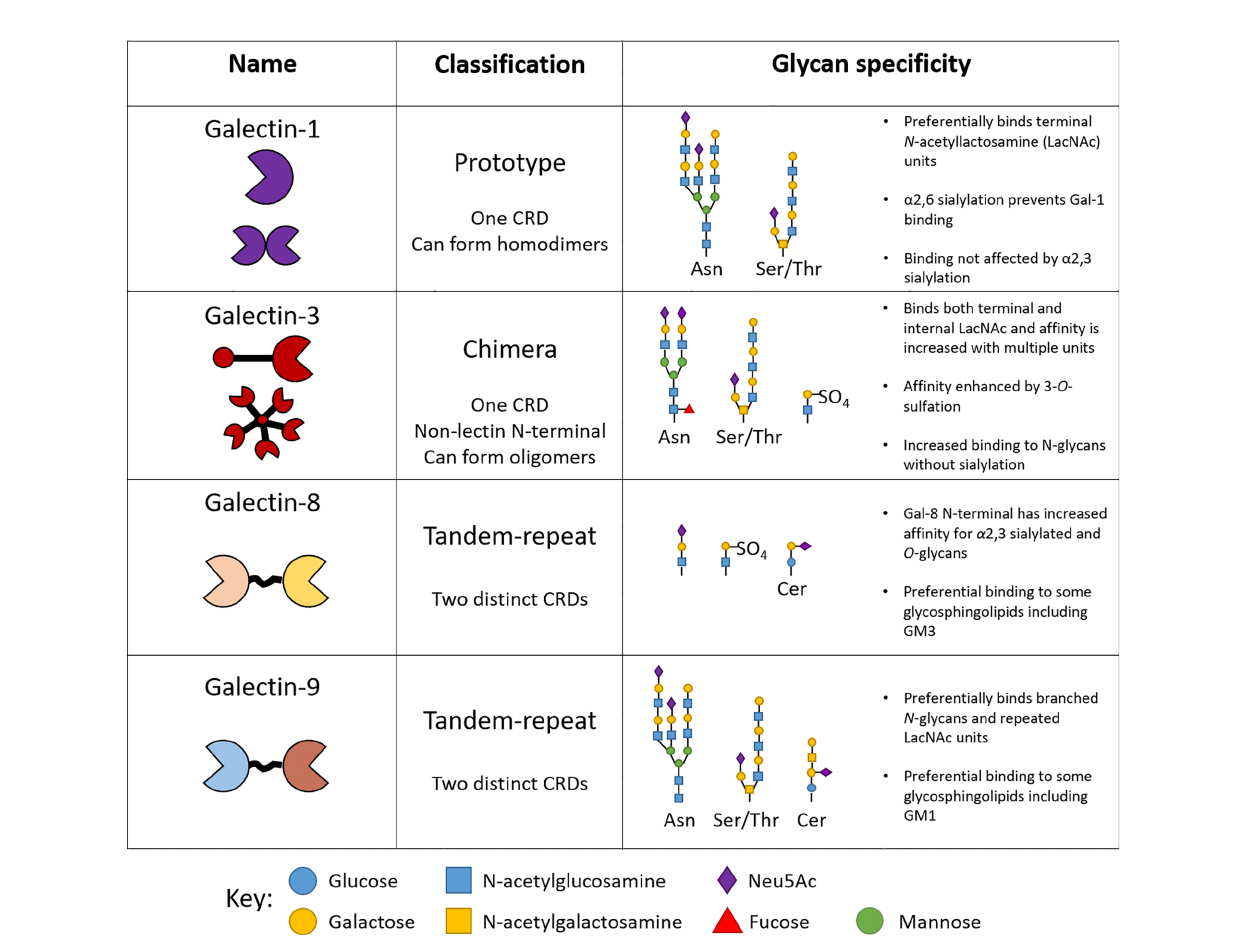
FIGURE 2 | Structure and speci fi city of human endothelial-expressed b -galactoside binding galectins. The classi fi cation of galectinsinto prototype, tandem-repeat and chimera types isbased on the number of carbohydrate recognition domains (CRDs) they contain. Each galectin type reserves highspeci fi city for certain glycan